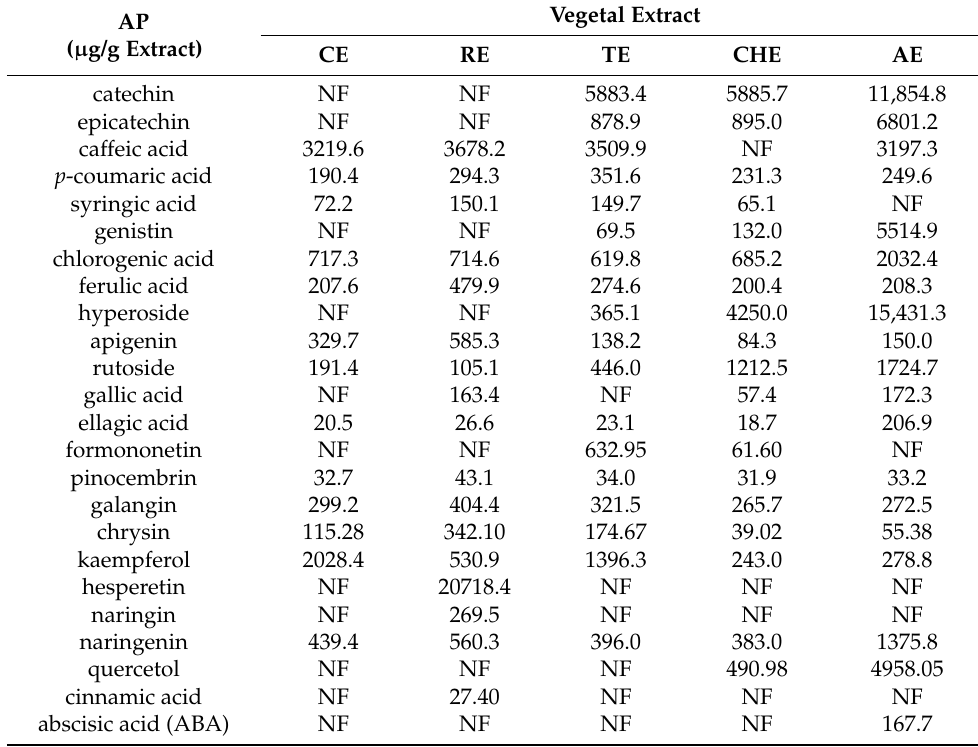
Table 7. Polyphenolic compounds quantified in vegetal extracts by UHPLC–HRMS/MS. Vegetal Extract AP ( µ g/g Extract) CE